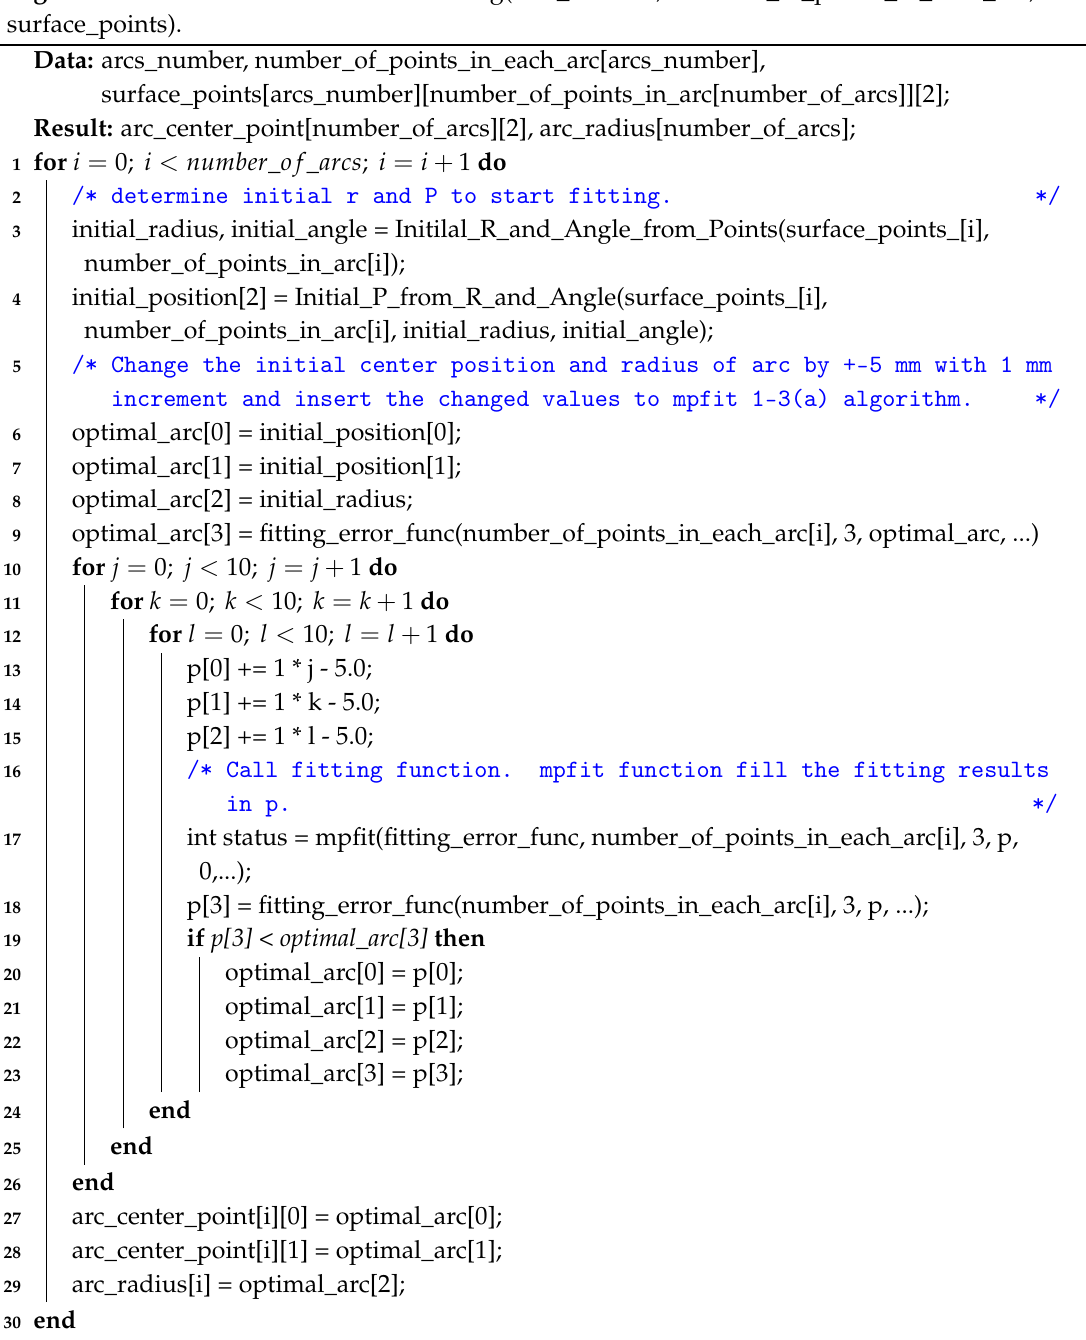
Algorithm A1: Piecewise arc curve fitting(arcs_number, number_of_points_in_each_arc,